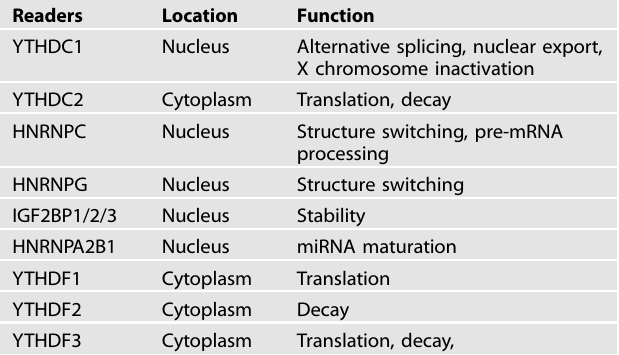
Table 1. The location and function of m6A readers.